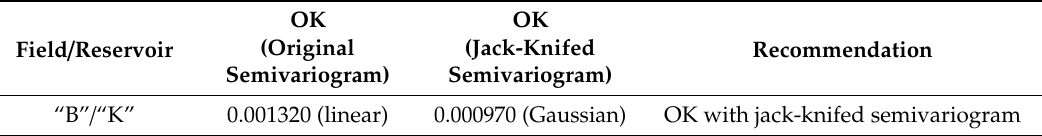
Table 2. Comparison of cross-validation (MSE) values for OK maps based on original and “jack-knifed” semivariograms [40].